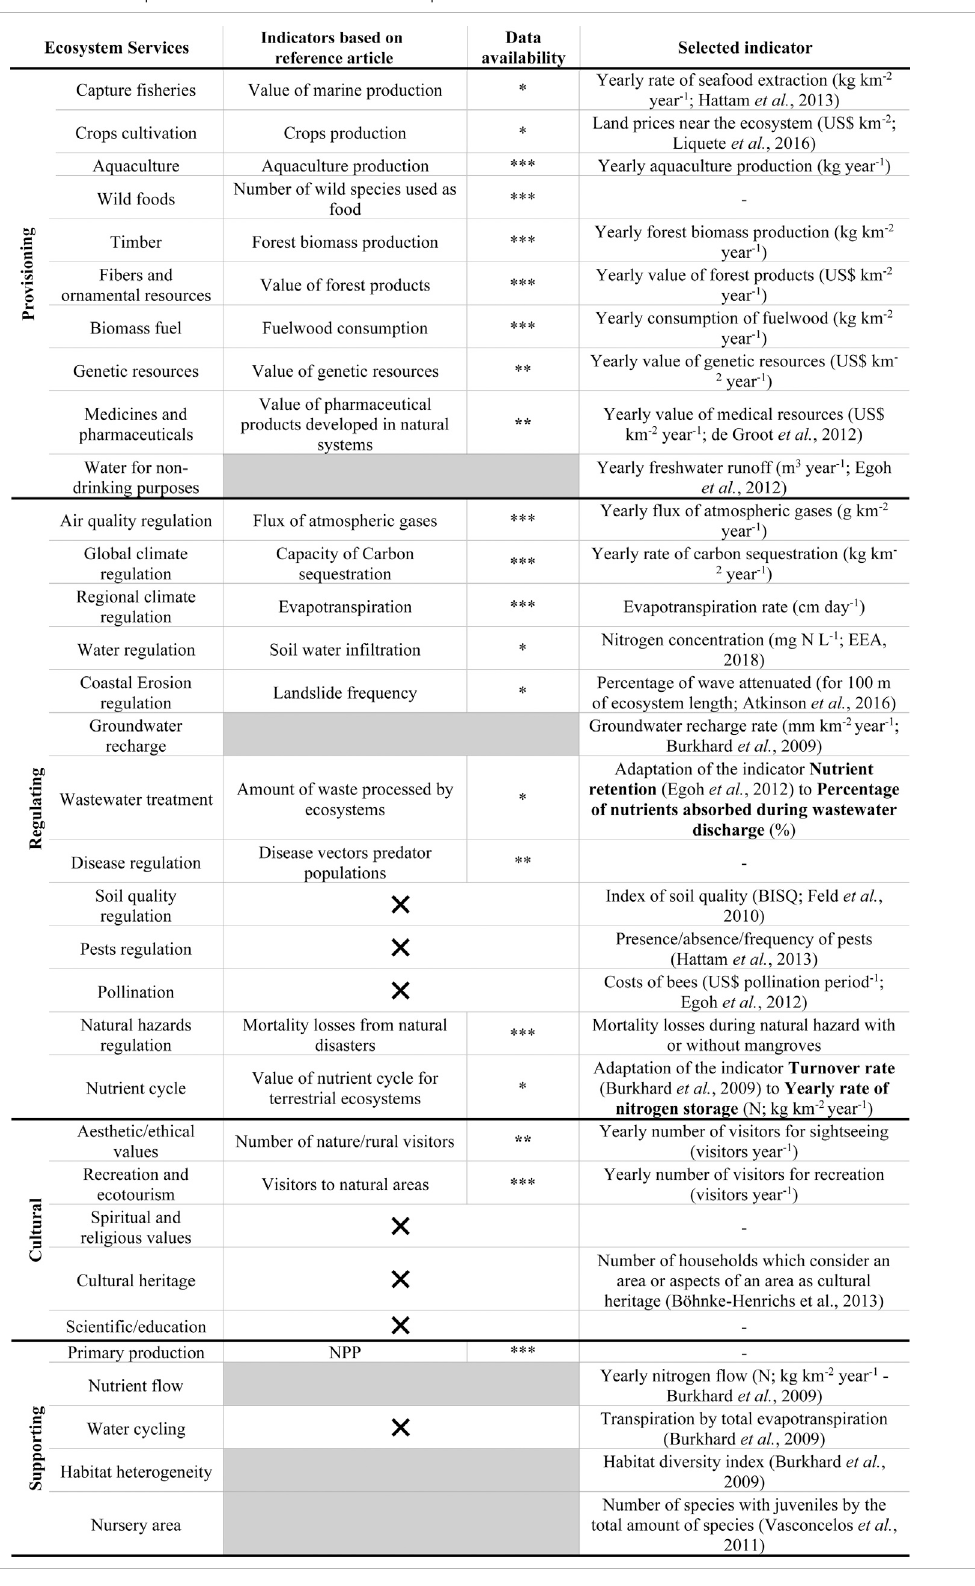
Frontiers in Environmental Science |